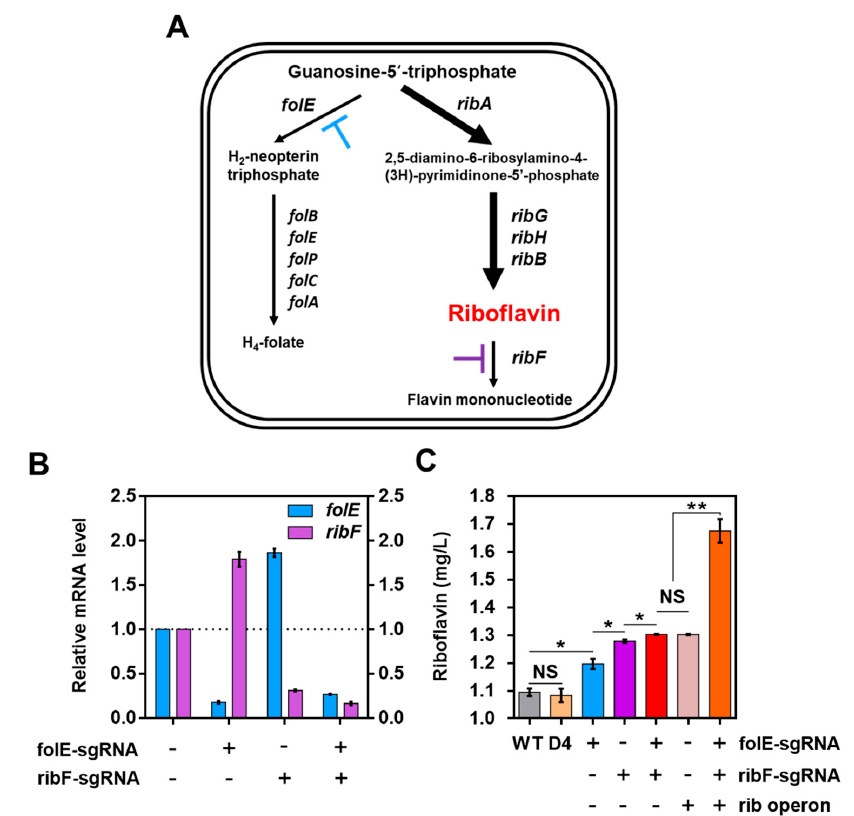
Figure 5. ( A ) Schematic diagram of the biosynthesis pathway of riboflavin in L. citreum . Blue and purple T-shaped bars represent the repression by CRISPRi with folE and ribF -specific sgRNA, respectively. ( B ) Transcription analysis of the folE and ribF genes by qRT-PCR. Blue and purple bars represent the transcription of folE and ribF genes, respectively. All the error bars represent the value of the standard deviation, which was calculated from three repeated experiments. ( C ) Identification of riboflavin accumulation via the designed CRISPRi system and the verification of the synergetic e ff ect of riboflavin accumulation via combination with the CRISPRi system and the rib operon expression cassette. Wild-type (WT), L. citreum CB2567; D4, L. citreum CB2567 harboring plasmid pD4. The error bars represent the standard deviation of the samples. NS represents nonsignificant ( p -value > 0.05), * p -value < 0.05, ** p -value < 0.01 based on the Student t